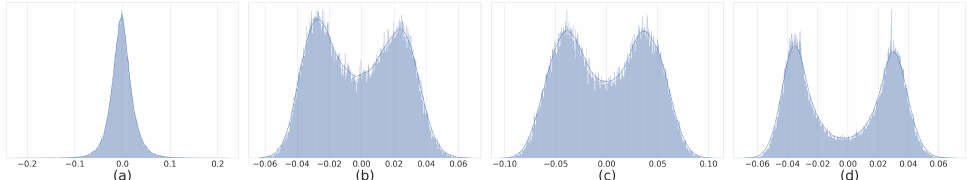
Figure 6. An example of the distribution of a filter from the second layer of ResNet18 trained with the CIFAR10 dataset. We see the original weight distribution ( a ), the distribution with kurtosis loss with K T = 1.8 ( b ), with K T = 1 ( c ), and with K T that are set differently for each layer of the network ( d